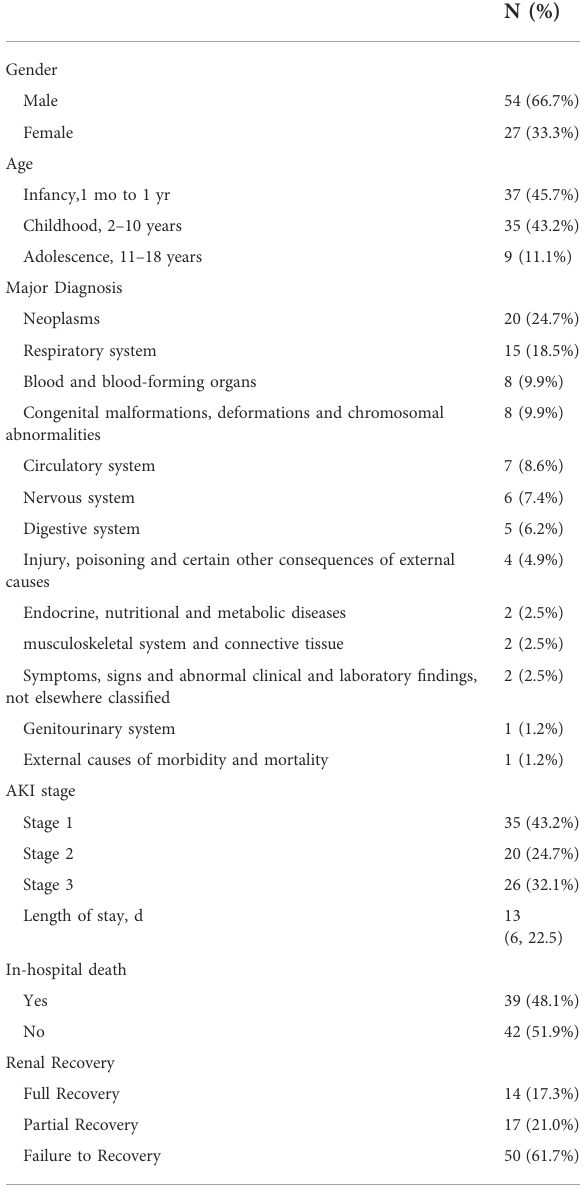
TABLE 1 Demographic information and clinical characteristics of patients with drug-induced kidney